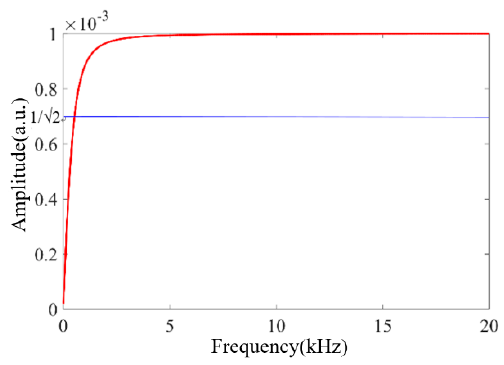
Figure 3. Calculated amplitude of H ( τ 2 ) as a function of frequency.